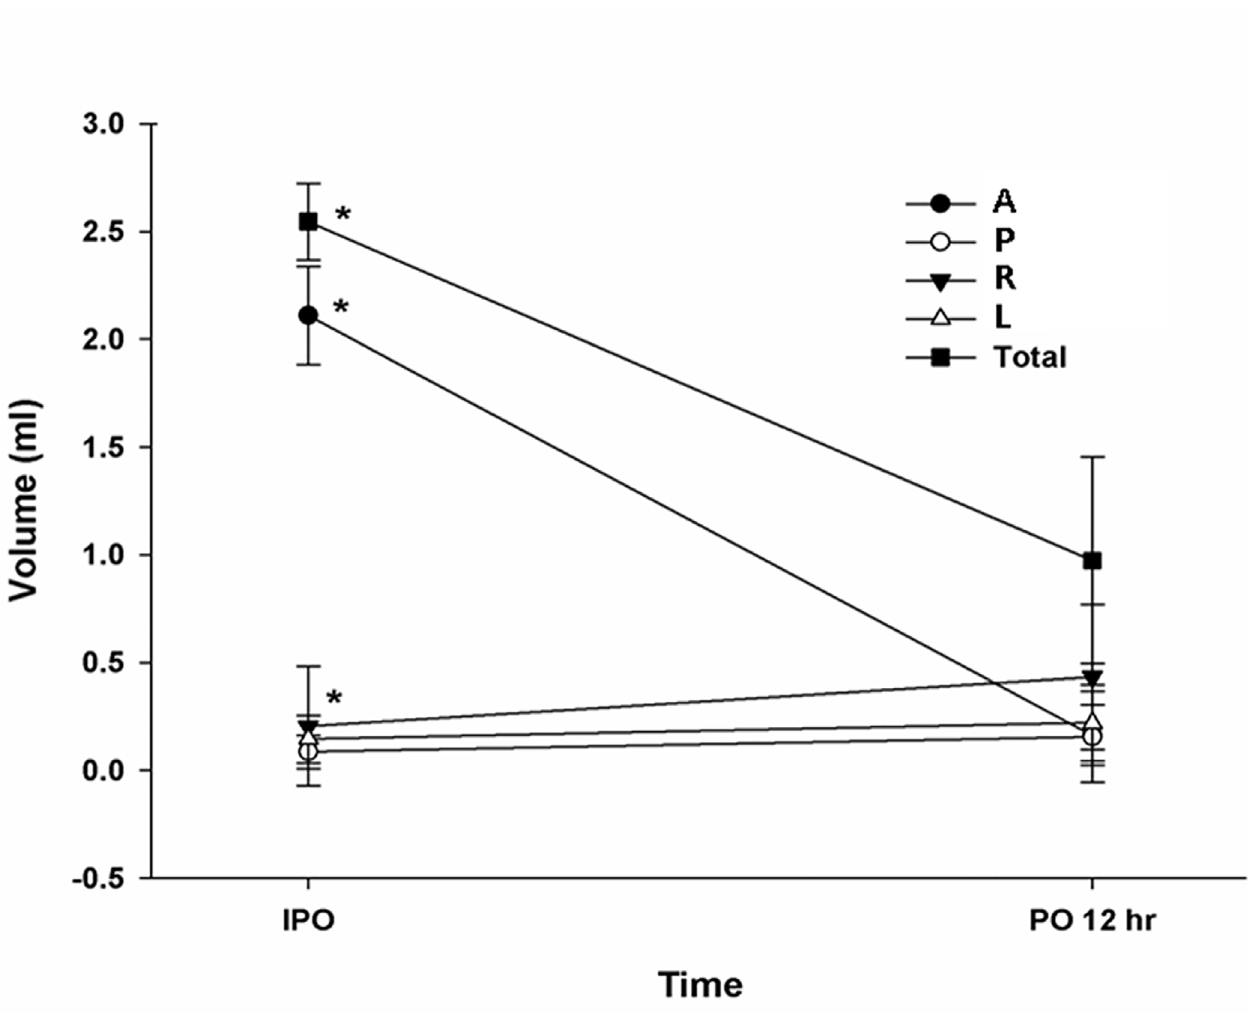
Fig 4. Changes in measured volume at each segment. A, anterior; P, posterior; L, left; R, right; IPO, immediately postoperative; PO 12 hr, postoperative 12